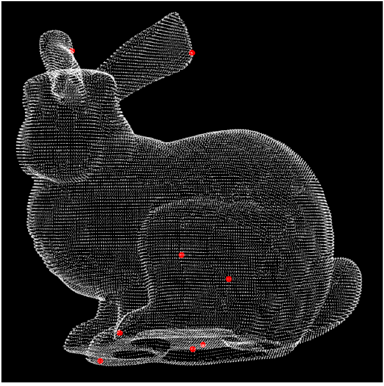
) in one layer, where σ = 0.05. i